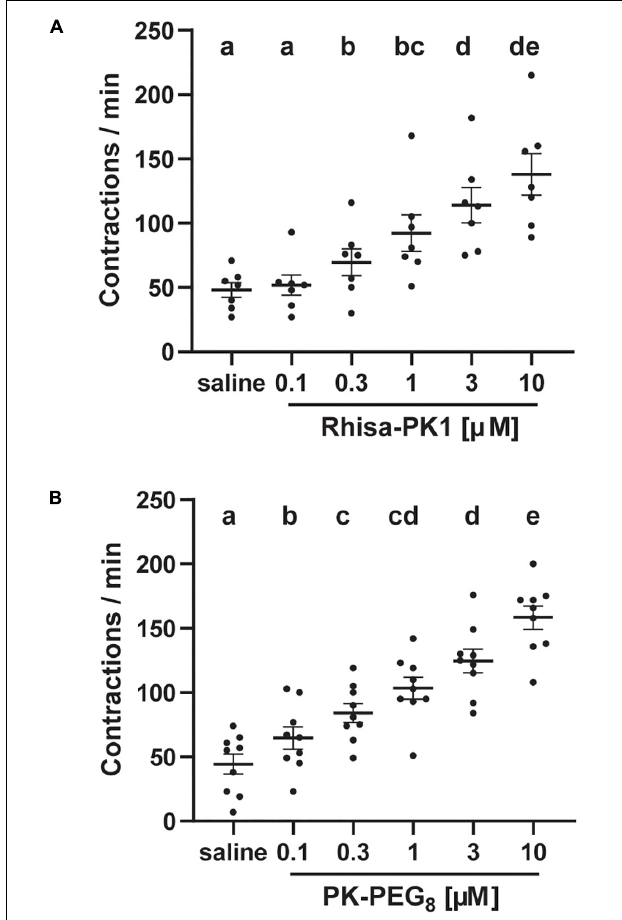
FIGURE 3 | Dose-dependent myotropic activity of a tick endogenous pyrokinin (A) and PK analog (B) on the pharynx-esophagus of Rhipicephalus sanguineus . Unfed female R. sanguineus ticks (2- to 3-month-old) were dissected under tick physiological saline to expose the pharynx-esophagus (see Figure 2 ). After dissection, ticks were transferred to a Sylgard plate into fresh saline (100 µ l). After 5 min of adaptation to the environment, the solution was replaced with 100 µ l of saline, and tissues were filmed to register any background contractions. Saline was replaced by 100 µ l of tick endogenous pyrokinin [Rhisa-CAPA-PK1 (RSNTFTPRIa)], or a PK analog [1944-P8 (MS[PEG 8 ]-YFTPRLa)] from low to high concentration. Tissue was rinsed (5 × 100 µ l of saline) between different concentrations. Tissue responses to